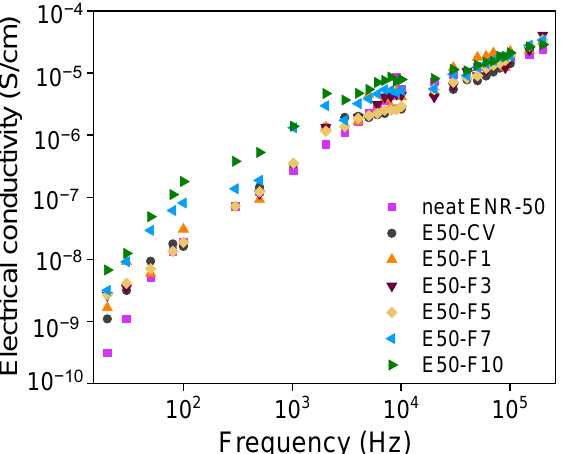
Figure 10. Electrical conductivity as a function of frequency of the neat ENR-50, ENR-50 compounded with various concentrations of FeCl 3 and the conventional sulfur vulcanizate (i.e., E50-CV).